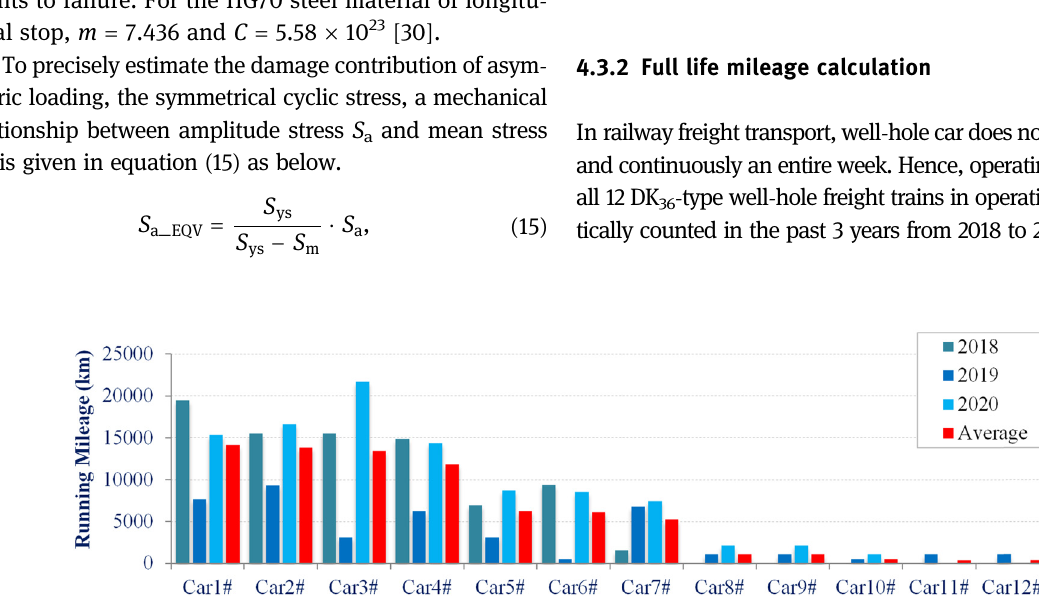
Figure 18: Running mileage histogram of DK 36 - type well - hole car in past 3 years.